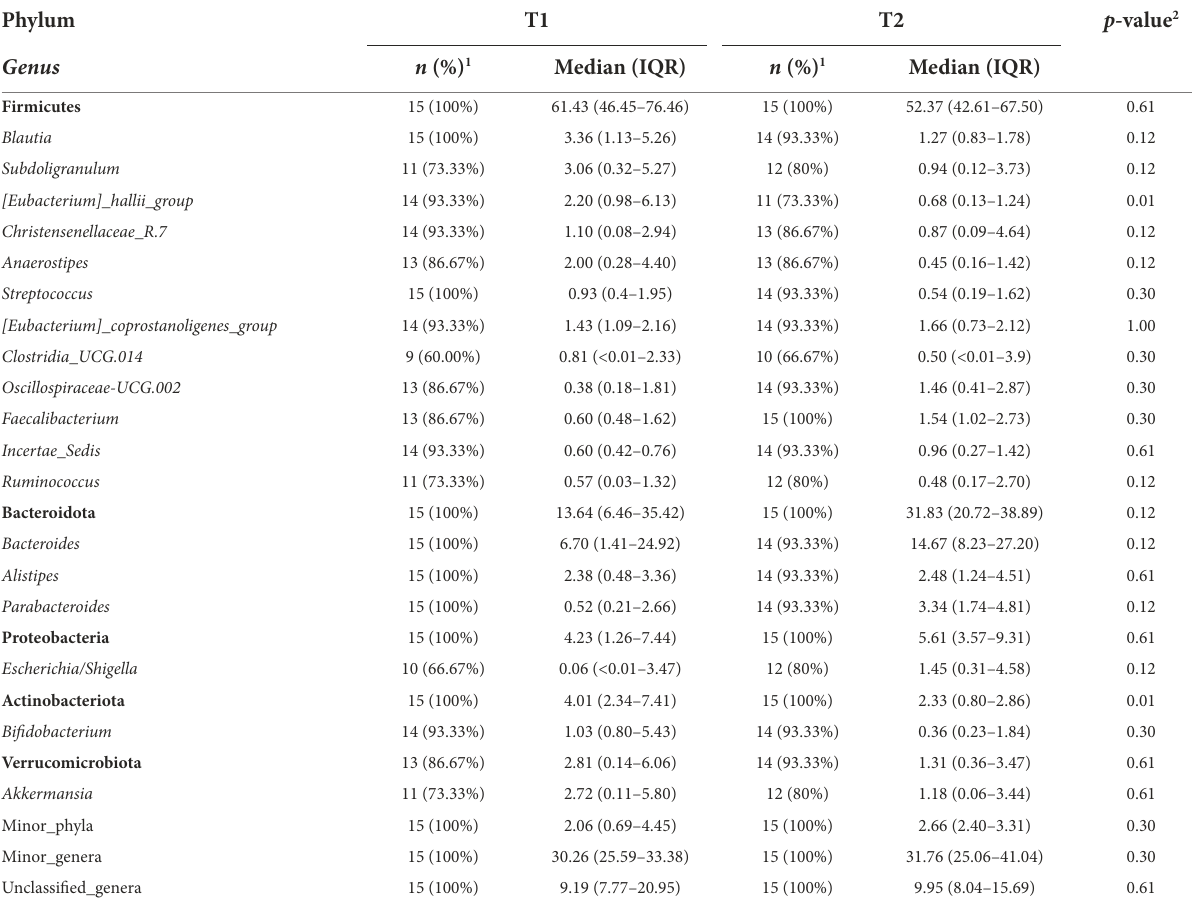
TABLE 3 Relative frequencies, medians and interquartile range (IQR) of the relative abundance (%) of the most abundant bacterial phyla (in bold) and genera (in italics) detected in the nasal samples collected at day 0 (T1) and 120